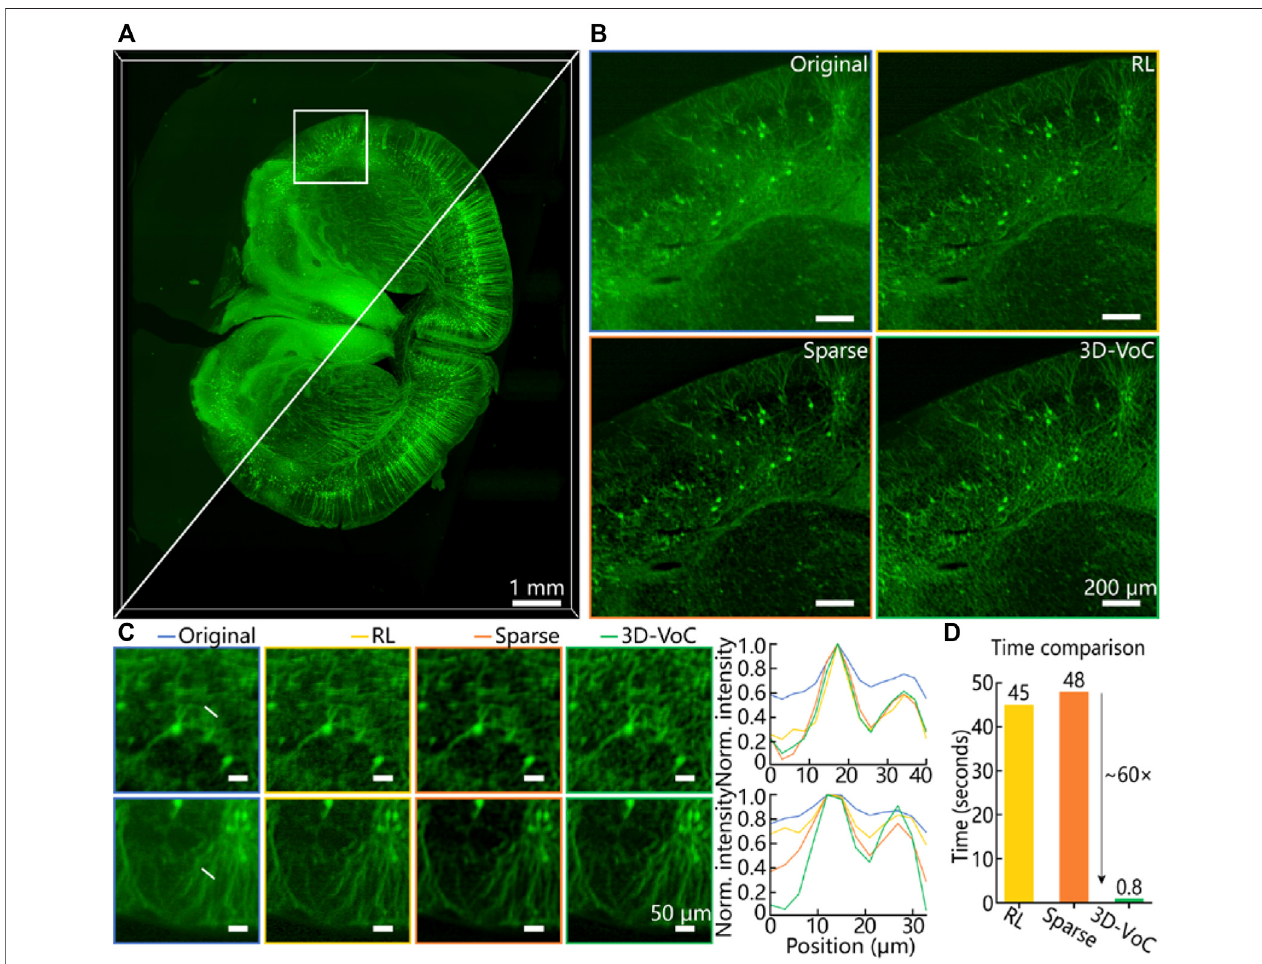
FIGURE 2 | The image enhancement performance of 3D-VoCycleGAN. (A) The comparison results before and after using 3D-VoCyleGAN (B) The image quality enhancement results with Richardson-Lucy deconvolution, sparse deconvolution, and 3D-VoCycleGAN method. The size of cropped image volume was limited by the GPU memory requirements of Richardson-Lucy deconvolution and sparse deconvolution. (C) The quantitative evaluation of the image quality enhancement performance. The plotting curves of two line pro fi les showed the signal level and SBR of nerve fi ber in the brain slice (D) The time consumption of different image processing methods for the image volume. RL: Richardson-Lucy deconvolution, Sparse: sparse deconvolution, 3D-VoC: